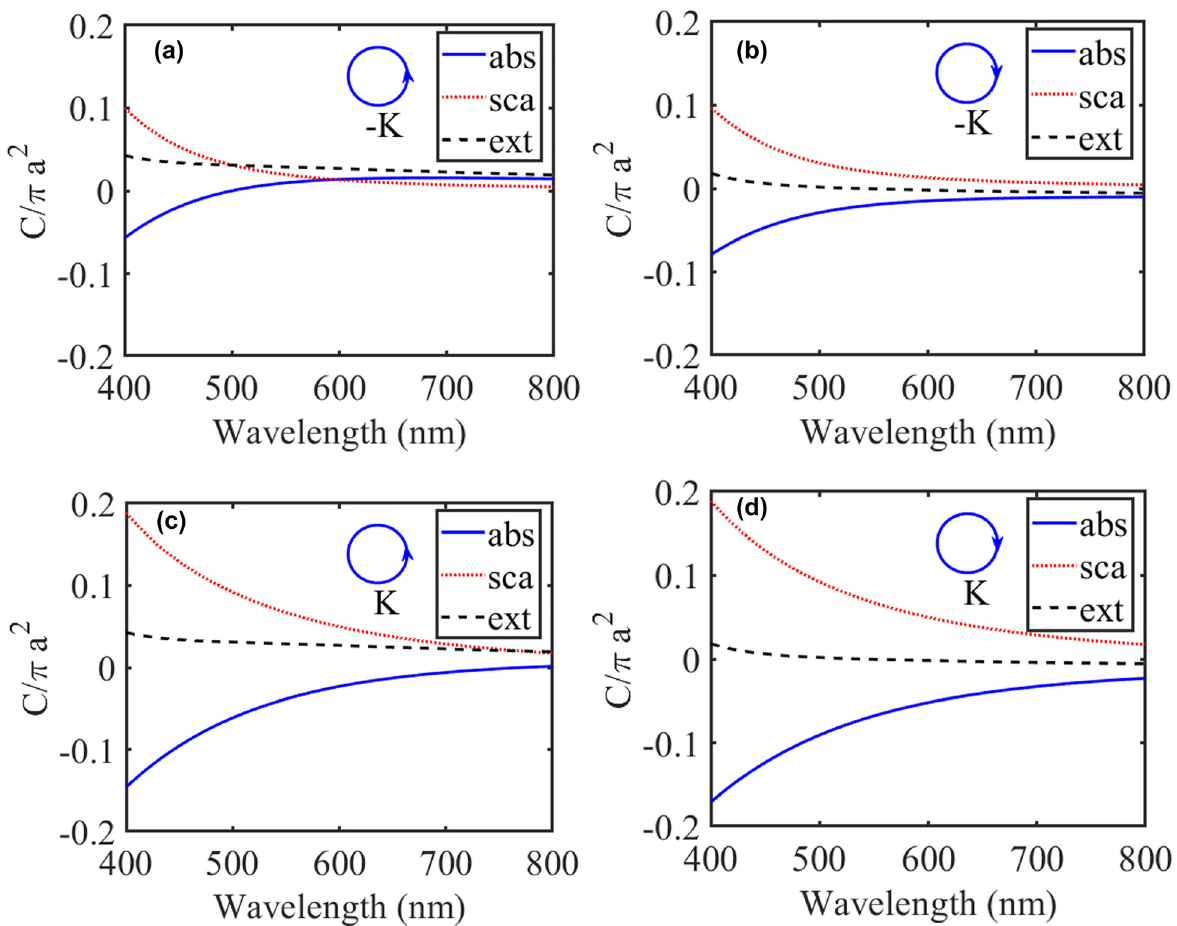
Figure 3: Normalized extinction (black dash lines), scattering (red dot lines), and absorption (blue lines) cross sections of the PT-symmetric chiralnanospheres.TheleftandRCPwavesareincidentfromthelossysphere(a)and(b)andfromthegainsphere(c)and(d),respectively.The chirality parameter and non-Hermiticity parameter are κ = 0 . 05 and δ = 0 . 5, respectively. The critical wavelength is λ EP = 550